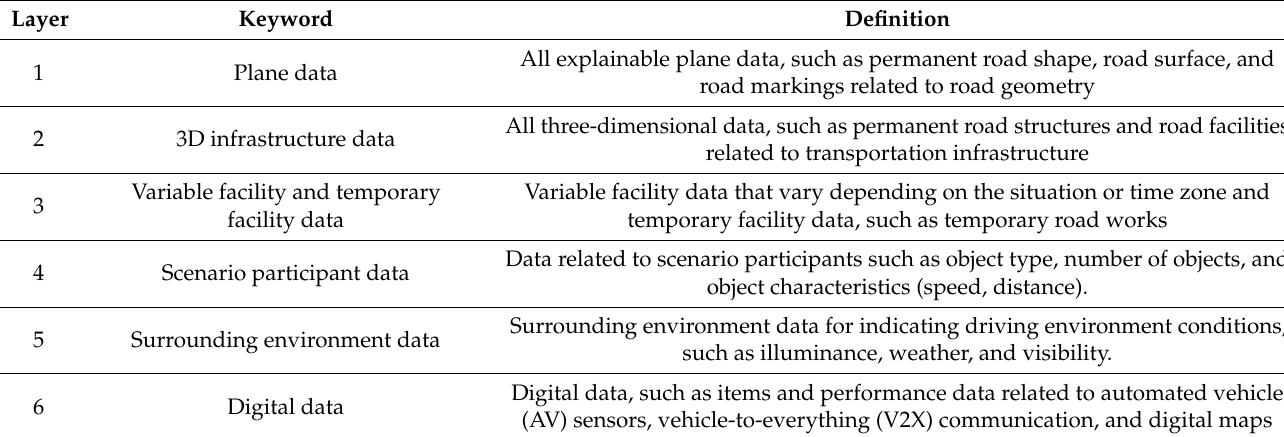
Table 1. New definition of the six-layer approach for this